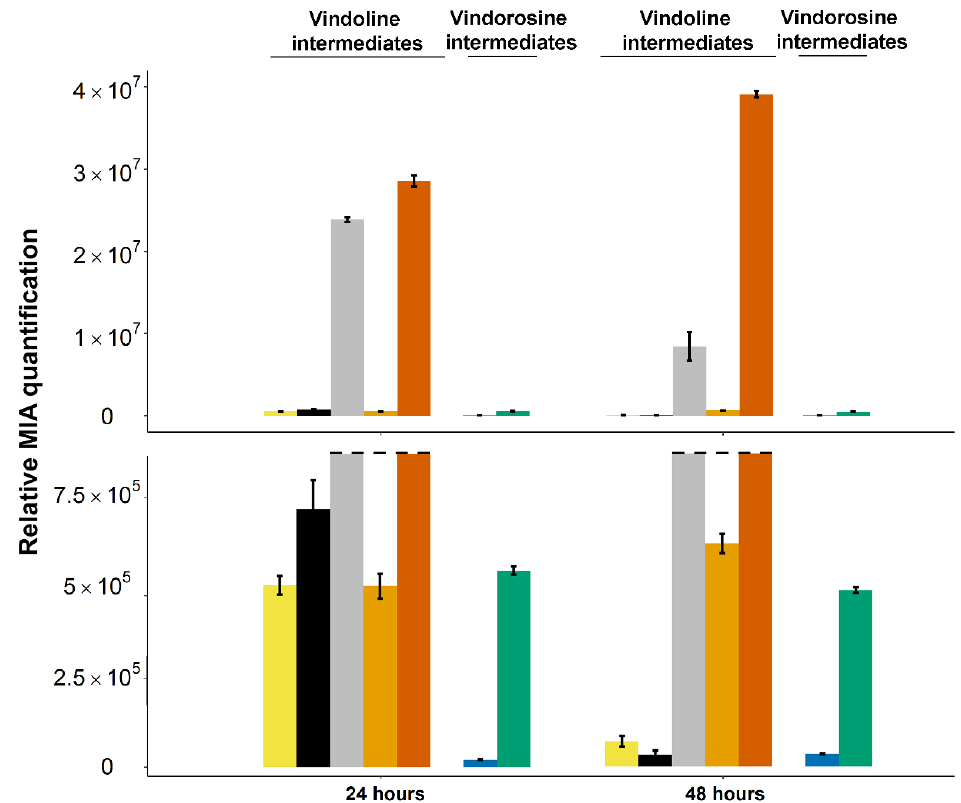
Figure 8. Evolution of MIA biosynthetic intermediates in the culture medium of yeast stably expressing two copies of T16H2 and C. roseus 16OMT and one copy of T3O and T3R (Stable_2(16OMT)s). Alkaloids were quantified by UPLC-MS in the yeast culture medium 24 h post-feeding with tabersonine (250 µ M). The dashed line represents the scale cut for the visualization of low accumulated intermediates. Light yellow = tabersonine, black = 16-hydroxytabersonine, grey = 16-methoxytabersonine, dark yellow = 16-methoxytabersonine epoxide, orange = 16-methoxy-2,3-dihydro-3-hydroxytabersonine, blue = tabersonine epoxide, green = 2,3-dihydro-3-hydroxytabersonine. Error bars correspond to the standard error of biological replicates ( n = 3). MIA composition of the yeast culture medium is expressed as relative peak